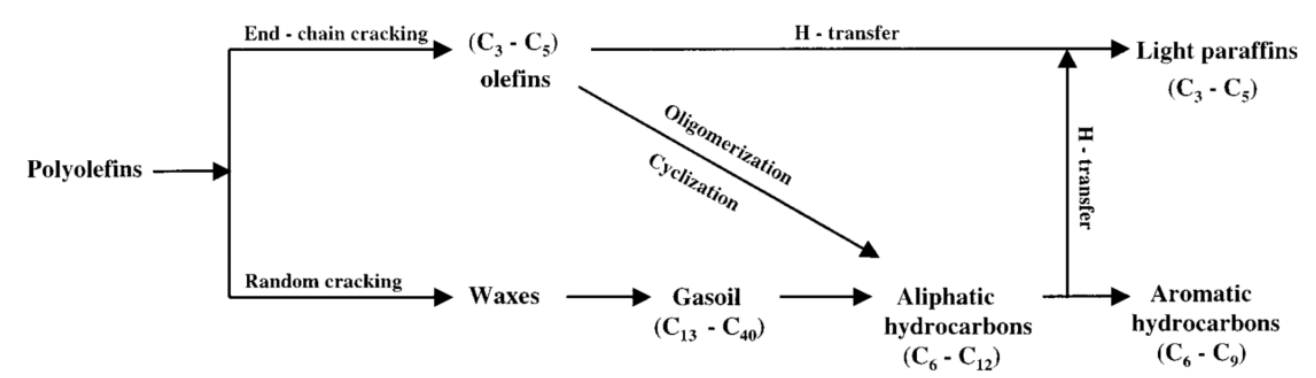
Figure 4. Reaction pathways for catalytic pyrolysis of polyolefins. Aguado et al. [53].